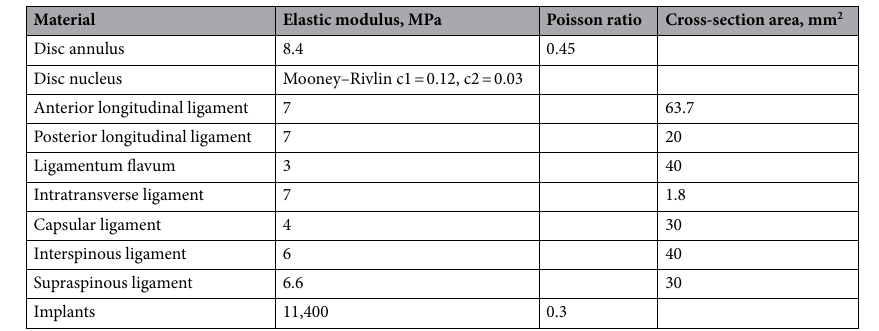
Table 1. Parameters of the lumbar spine model and implants.